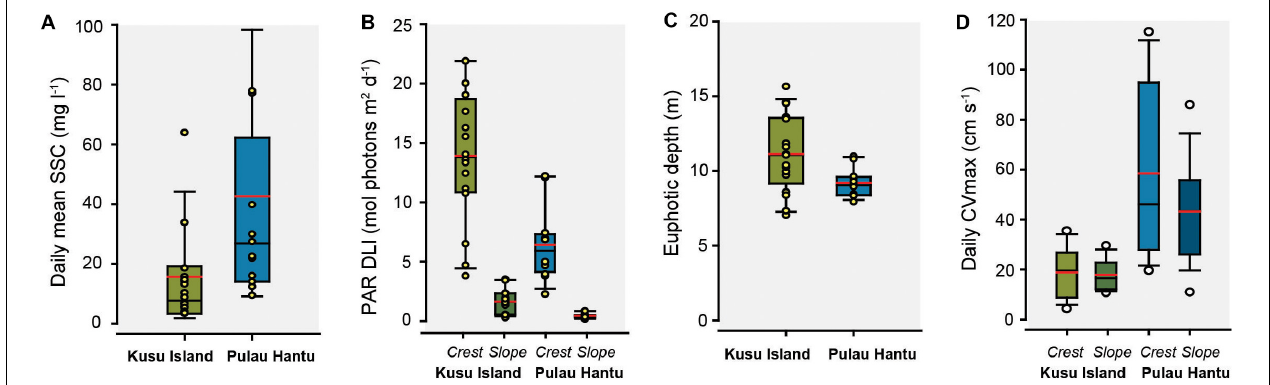
FIGURE 2 | Boxplots of (A) daily mean suspended sediment concentration (SSC: mg l − 1 ), (B) PAR daily light integral (DLI: mol photons m − 2 day − 1 ), (C) euphotic depth (Zd: m), and (D) daily maximum current velocity (CV max : cm s − 1 ) at reef crest and reef slope sites on Kusu Island (green) and Pulau Hantu (blue). Red lines show mean values. Circles represent the daily values recorded of each parameter.